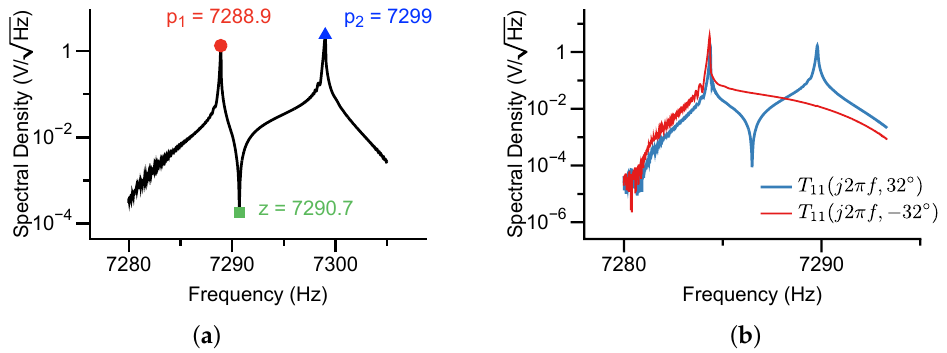
Figure 15. The measured amplitude spectral density of the chirp-driven frequency response from the direction of 0 ◦ ( a ). The measured amplitude-frequency responses along the directions of 32 ◦ and − 32 ◦ ( b ). The sweep duration was 70s and the frequency bandwidth was